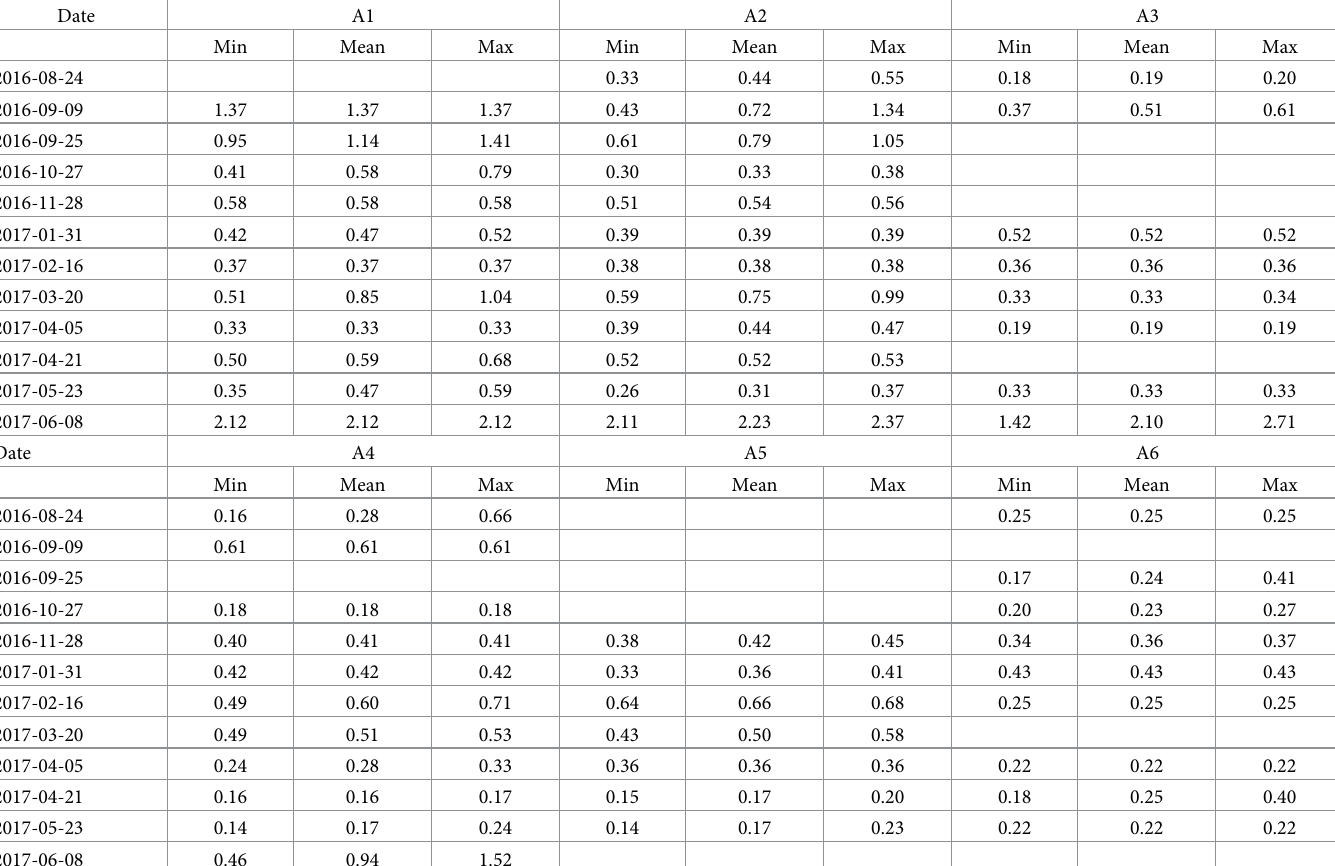
Table 1. Descriptive statistics of in situ -measured Chlorophyll-a concentrations ( μ g � l -1